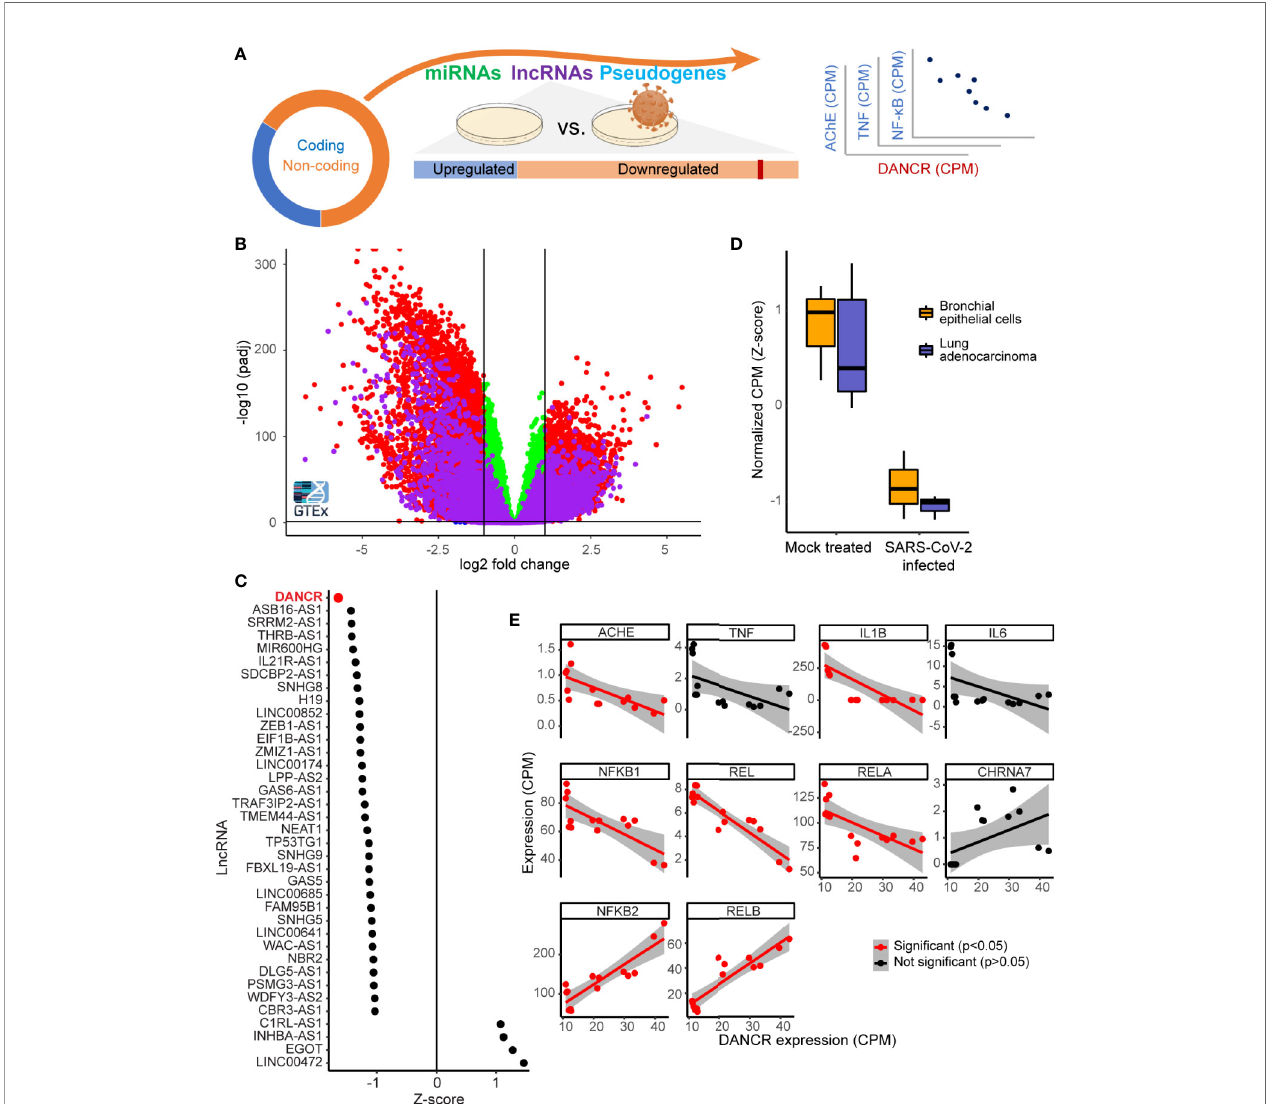
FIGURE 1 | DANCR is downregulated in SARS-CoV-2 infected lung cells and in GTEx in fl ammation-prone lung samples. (A) The majority of the transcriptome (circle) consists of non-coding-RNA, including miRs, lncRNAs, and other RNAs. Changes in lncRNAs were assessed in viral-infected lung cell lines and in fl ammation- prone GTEx donors, and the expression levels of the down-regulated lncRNA DANCR was compared to those of in fl ammation-related coding transcripts. (B) Volcano plot showing coding transcripts (red and green) and lncRNAs (purple) from lung and blood samples of healthy post-mortem donors (n=419 and 407, respectively) with or without in fl ammatory reactions. Horizontal line represents p = 0.05 and vertical lines indicate -1/1 log2 of fold change. (C) 69% of the lncRNAs expressed in NHBE or A549 lung cells were downregulated [shown are only those with p value <0.05; of those, only DANCR had adjusted p < 0.05 (FDR)]. (D) DANCR is downregulated under viral infection both in bronchial epithelial cells and in lung adenocarcinoma cells [NHBE, p < 0.013; A549, p < 0.008; t. test (FDR)]. (E) DANCR expression change was signi fi cantly correlated (red, p < 0.05, FDR) with those of the cholinergic-associated AChE, multiple cytokines and NFkB subunits in both SARS-CoV-2 infected and control lung cell